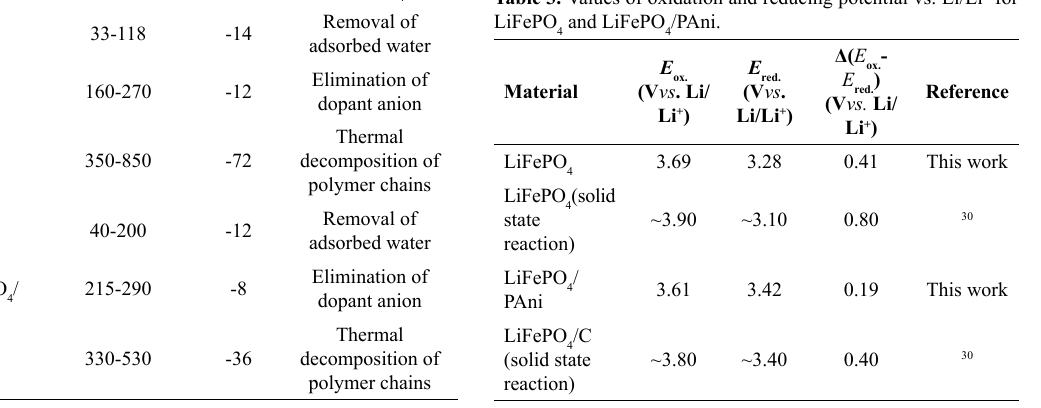
Table 2. Temperatures values of thermal events for LiFePO and LiFePO /PAni. 4